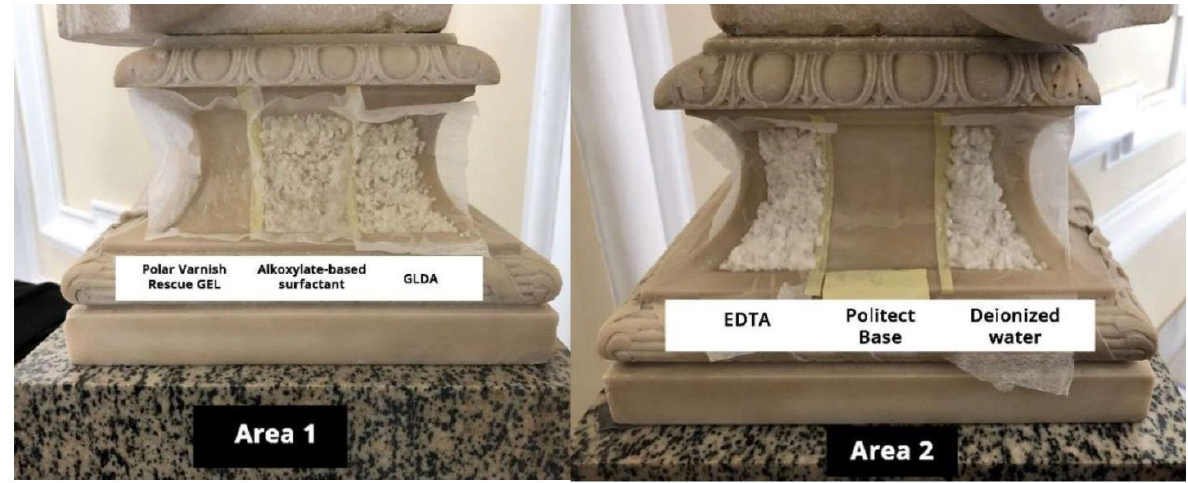
Figure 3. Product application on the base as described in Table 3. Table 3. CIELab coordinates on the measuring points and color simulation (c.s.) in the Hex color system.